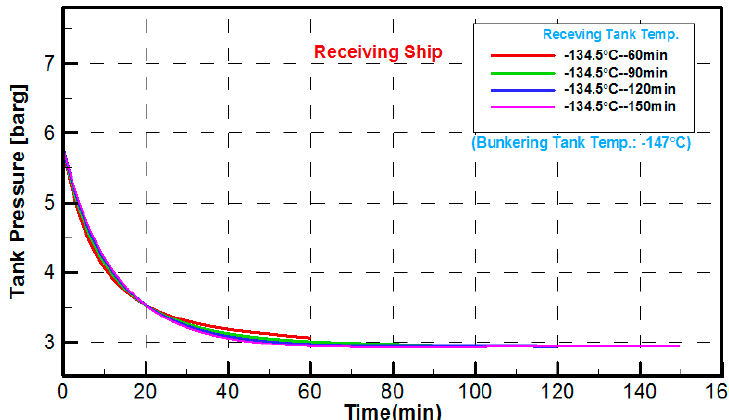
Figure 7. Pressure variation in the bunker cargo tank of the bunkering ship during the bunkering operation at different bunkering time limits.